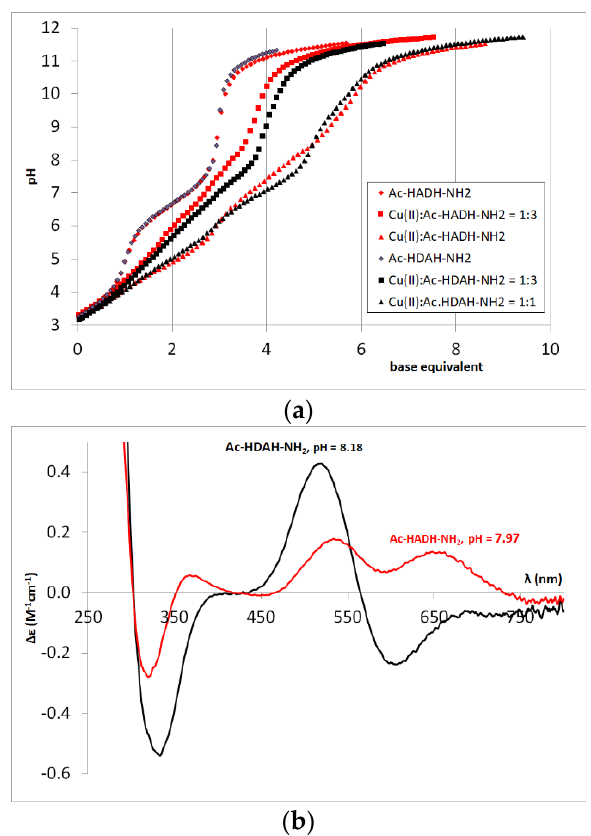
Figure 4. Titration curves of L, Cu(II)-L = 1:3 and 1:1 systems (L = Ac-HADH-NH 2 , Ac-HDAH-NH 2 ) ( a ); CD spectra registered in equimolar solution of Ac-HADH-NH 2 ( ■ ) and Ac-HDAH-NH 2 ( ■ ) systems at pH 8 (c L = 2 mM) ( b ).